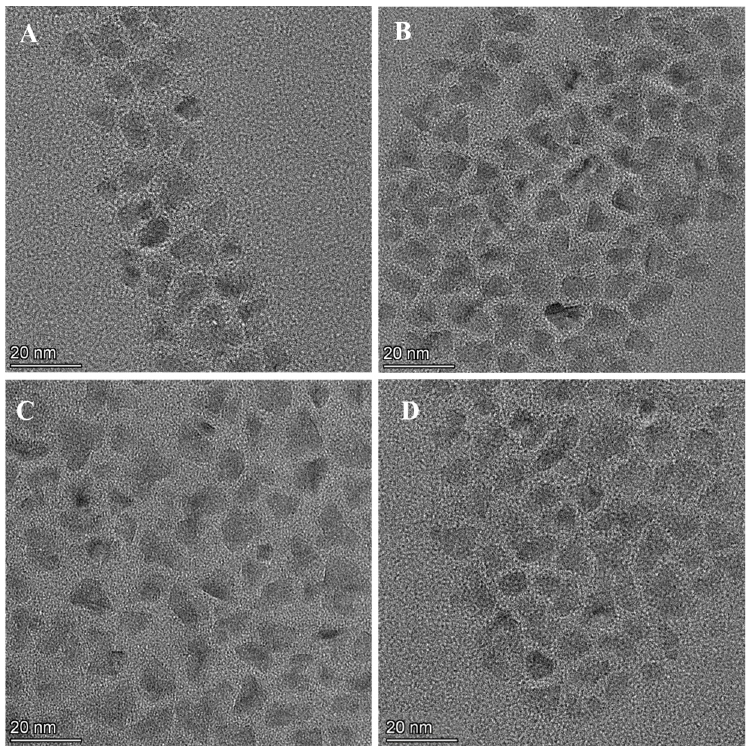
Figure 2. TEM images of ( A ) InP/ZnSe/ZnS and ( B ) InP/ZnSe/ZnS:Zr (with the ratio of S/Zr = 1:4) QDs before irradiation of LED. TEM images of ( C ) InP/ZnSe/ZnS and ( D ) InP/ZnSe/ZnS:Zr (with the ratio of S/Zr = 1:4) QDs after irradiation of LED.